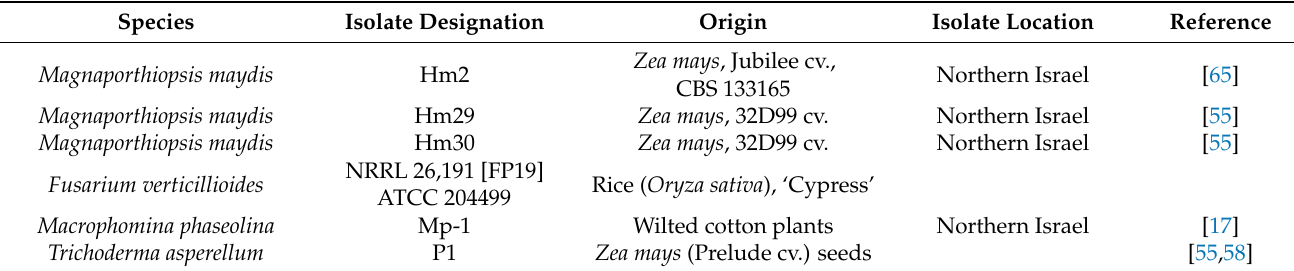
Table 1. Fungi used in this